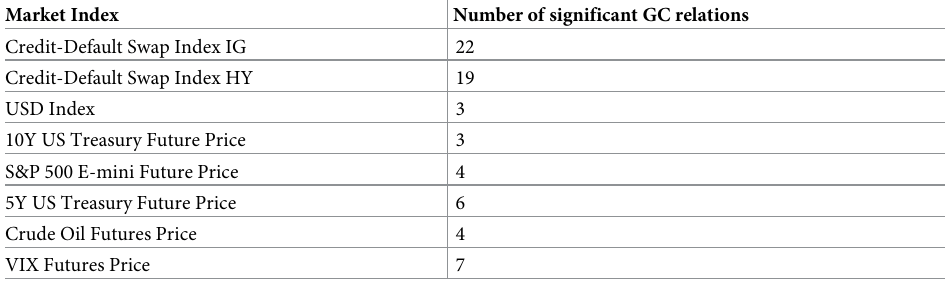
Table 2. The number of statistically significant Granger causality relations between each market index and trad- ers’ PP activation, with Holm-Bonferroni correction at 5% significance